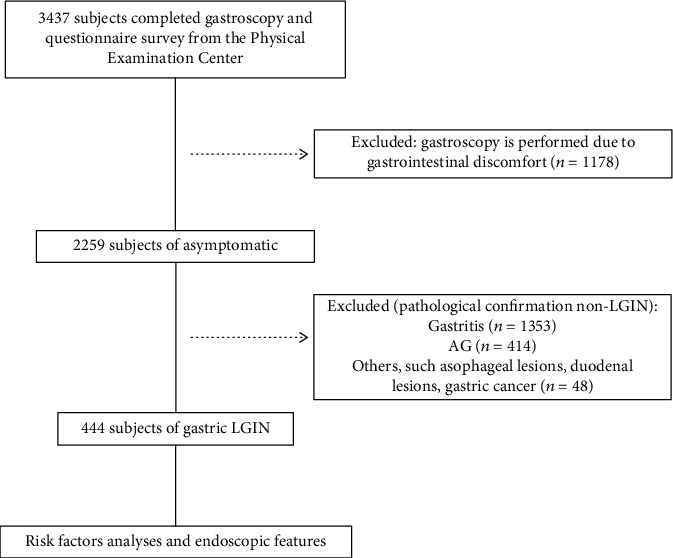
Flow chart for selecting the research population.